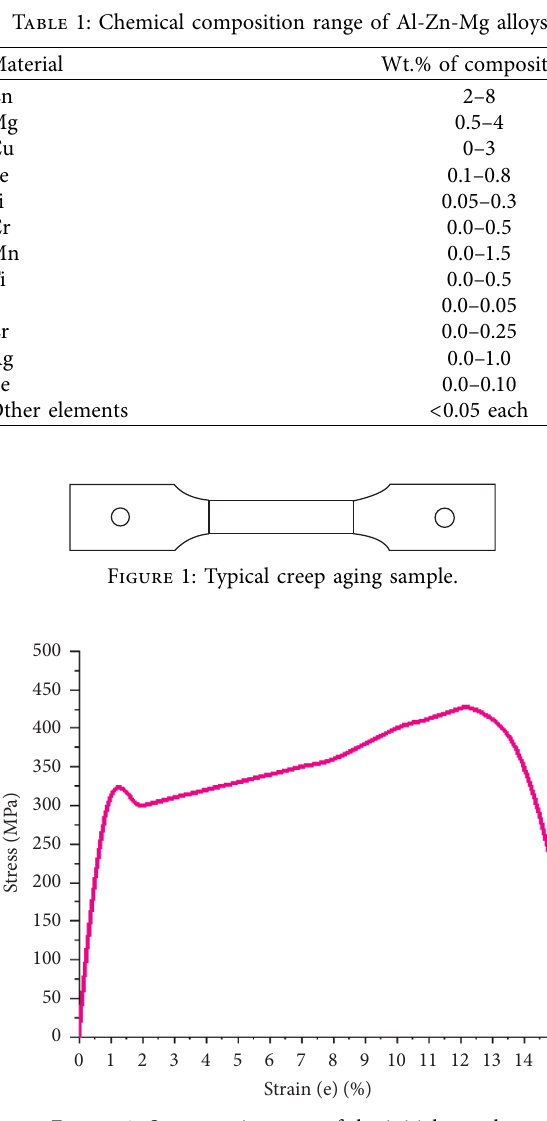
Figure 2: Stress-strain curve of the initial sample.